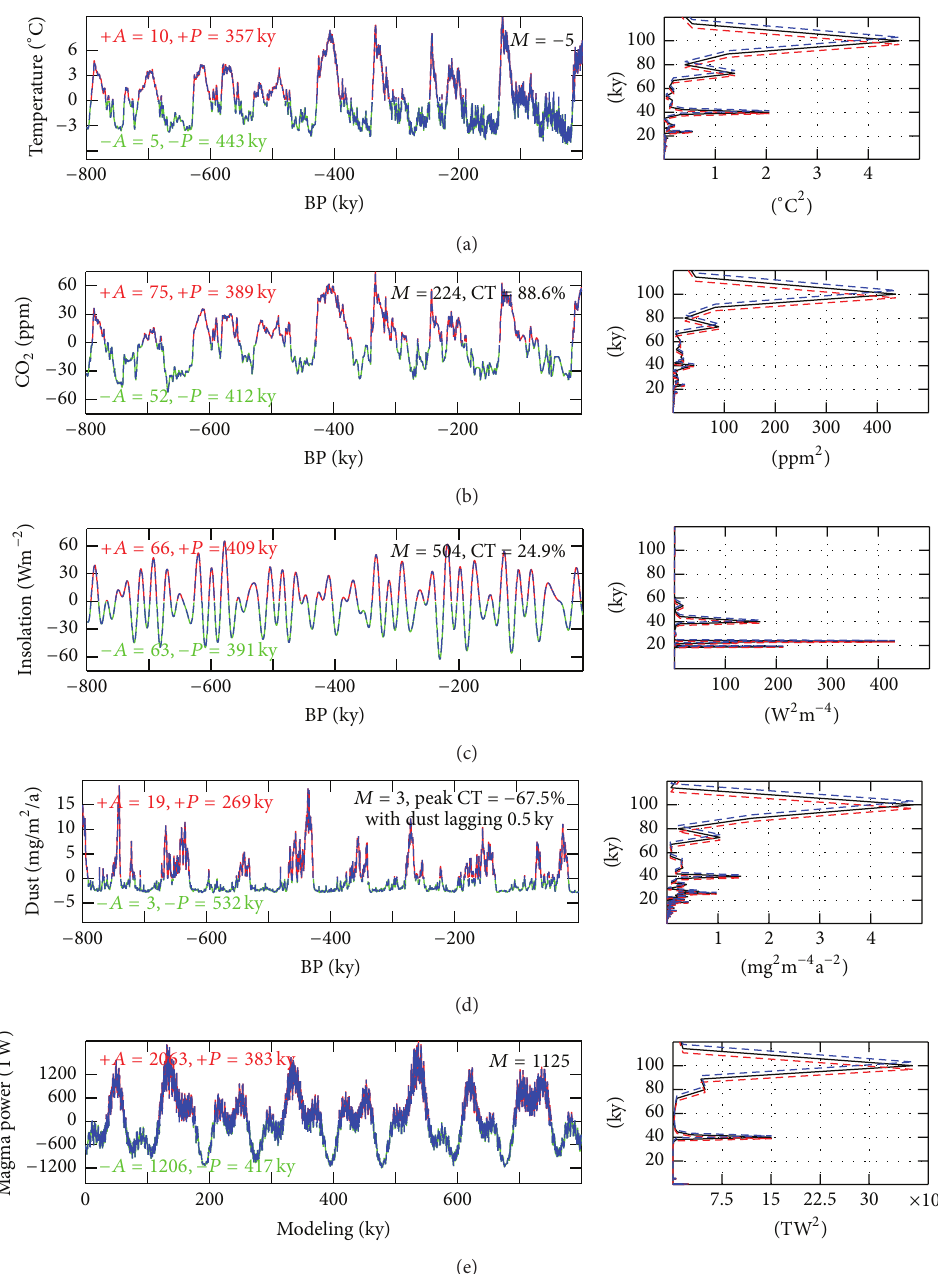
Figure 1: A time series with the mean deducted (left column, data interval is 0.1ky) and its squared amplitude spectrum (right column) for temperature (Row a), CO 2 (Row b), insolation (i.e., Milankovitch cycle, Row c), and dust (Row d) from the EPICA Ice Core during July at 65 ∘ N for the past 800,000 years [6, 10, 11], as well as the total PSMGIM (1TW = 10 12 W, Row e, using cf = 0.001 s −1 , 𝑢 𝑞 , V 𝑞 = 2.4 and 4 𝜇 m/s; for the lower mantle and outer core, resp., see Section 2). Left column: the time series (red-green curve) was 100% correlated to its reconstruction (dashed blue curve) that was produced via the Discrete Fourier Transform (see Methods, Section 2.3), with a confidence of 99.99%, and was evaluated using the following: the positive/negative amplitude (+𝐴/ − 𝐴) , the total phase length during positive-/negative-phases (+𝑃/ − 𝑃) , the mean (𝑀) , and the correlation to temperature (CT). Right column: the squared amplitude spectrum (see Methods, Section 2.3, black curve) with the 𝑥 -axis representing the value and the 𝑦 -axis representing the period (ky). Error bars were plotted with a dashed blue (upper limit) and red (lower limit) line, estimated via a chi-square test [8, 9] for a 95% significance